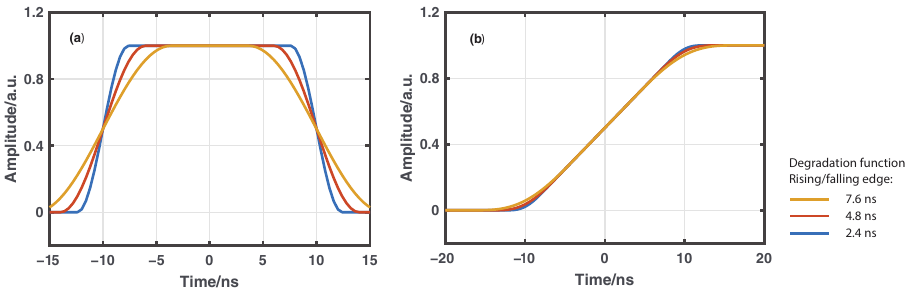
Figure 2. ( a ) Numerical generated degradation functions with the same FWHM of 20 ns but dif- ferent rising/falling edges of 7.6, 4.8, and 2.4 ns, ( b ) Rising edges of the corresponding simulated Raman